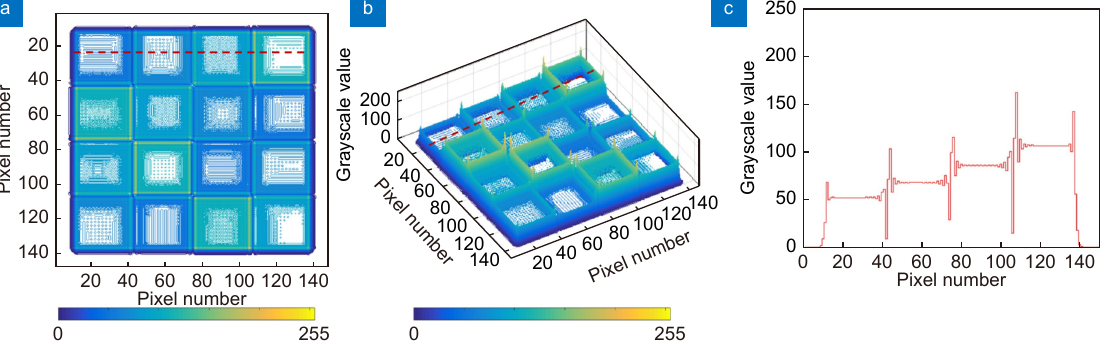
Fig. 4 | ( a ) Contour map of the intensity image in Fig. 3(c). ( b ) 3D contour map of the intensity image in Fig. 3(c). ( c ) Intensity distribution on the red line in (a) and